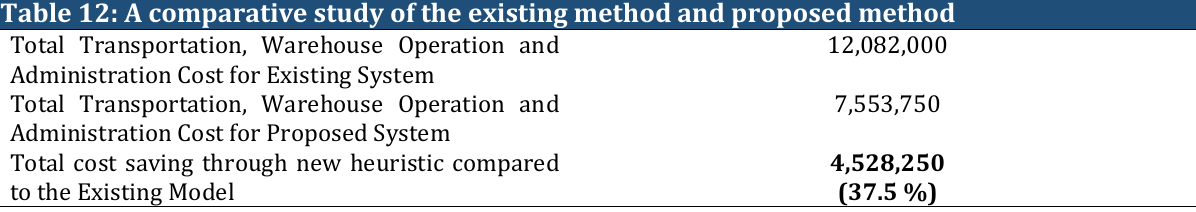
Table 12: A comparative study of the existing method and proposed method Total Transportation, Warehouse Operation